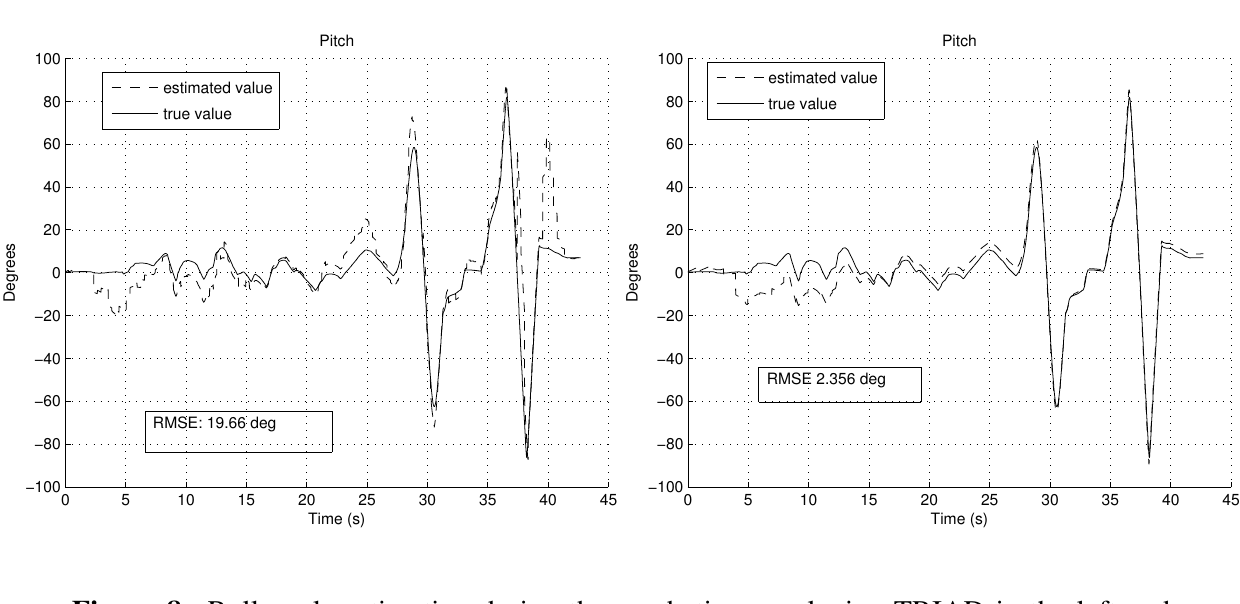
Figure 7. Pitch angle estimation during the aerobatics, employing TRIAD in the left and FOAM in the right during the aerobatics simulation shown in Figure 5.